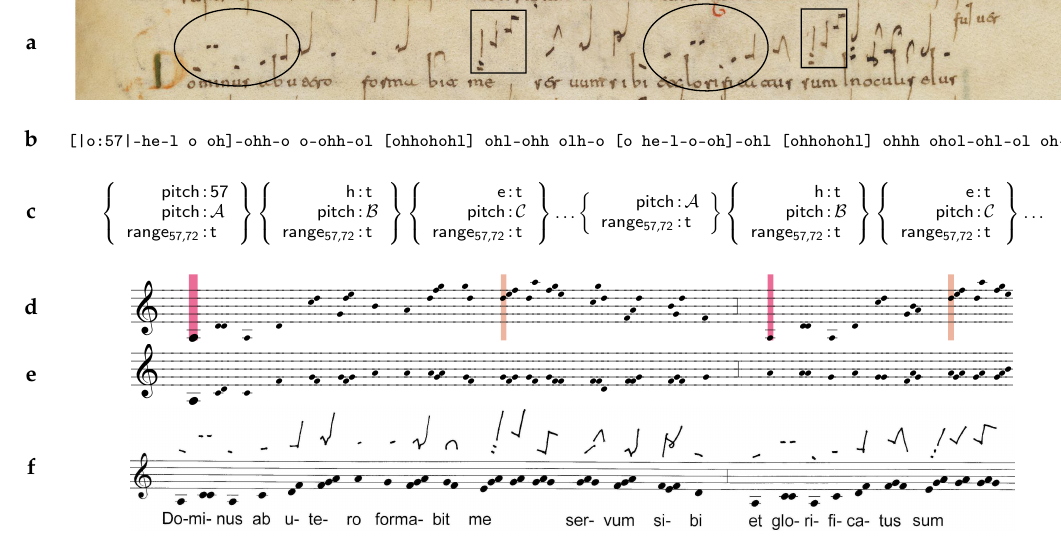
Figure 2. ( a ) The first line of the responsory Dominus ab utero for the feast of St. John the Baptist in the León antiphoner (E-L 8, 214r2), with two intra-opus patterns; ( b ) a representation of the fragment in contour letters (with intra-opus patterns bracketed); ( c ) the partial encoding of the contour sequence and intra-opus patterns as a template. A , B , and C are variables used to specify equal pitches; ( d ) a random instantiation of the template: the two different colors indicate the beginning event for the two intra-opus patterns; ( e ) a sample taken from a statistical model, ignoring any template constraints; ( f ) the corresponding passage of our generated performance